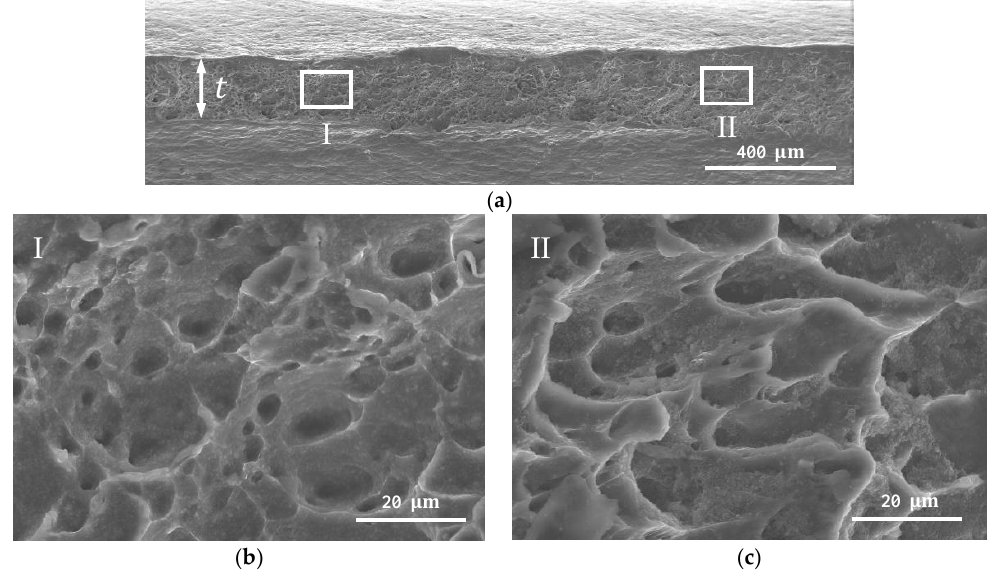
Figure 7. SEM of the fracture surface of an aluminium AA1050-H111 staggered DNTT specimen with 𝛼 = 60° . ( a ) Macro view of the fractured surface side with identification of the ( b ) tensile (mode I) and ( c ) in-plane shear (mode II) regions.